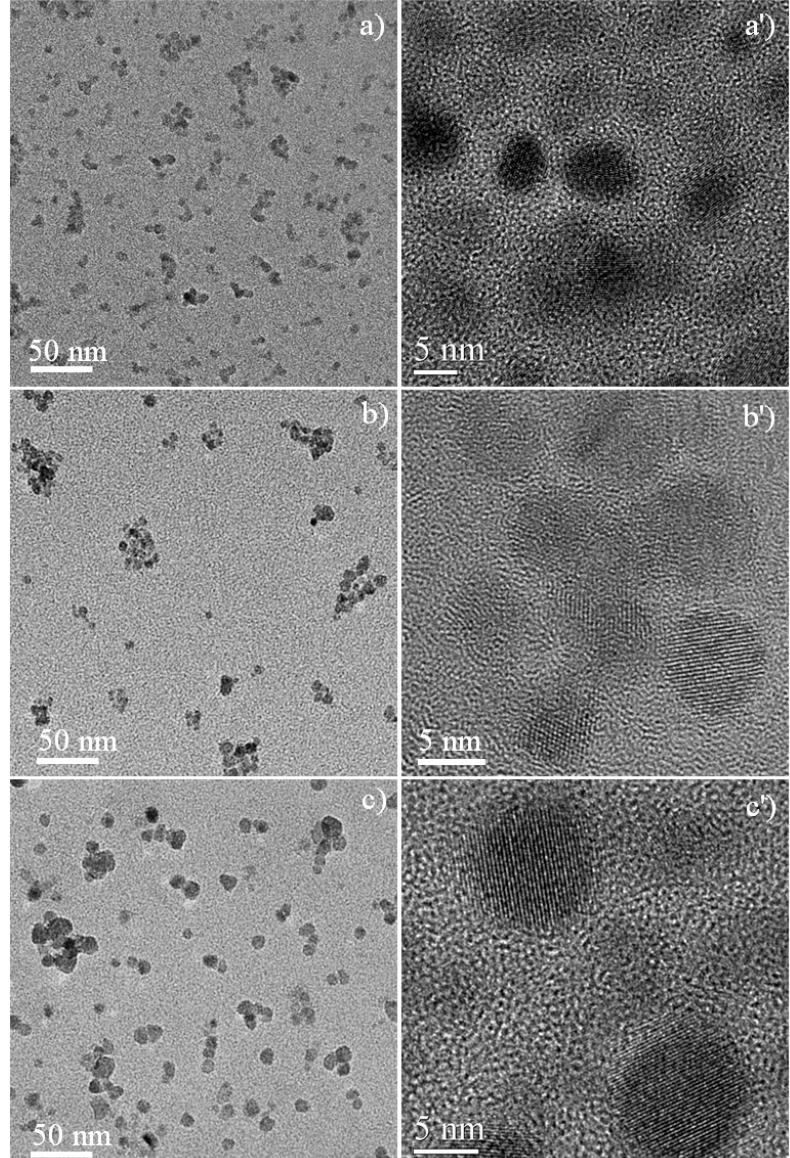
Figure 3. TEM and HRTEM images of representative nanocrystals of samples: a, a ʹ ) Q-ZnS-I; b, b ʹ ) Q-ZnS-I ʹ ; c, c ʹ ) Q-ZnS-I ʹʹ , respectively.